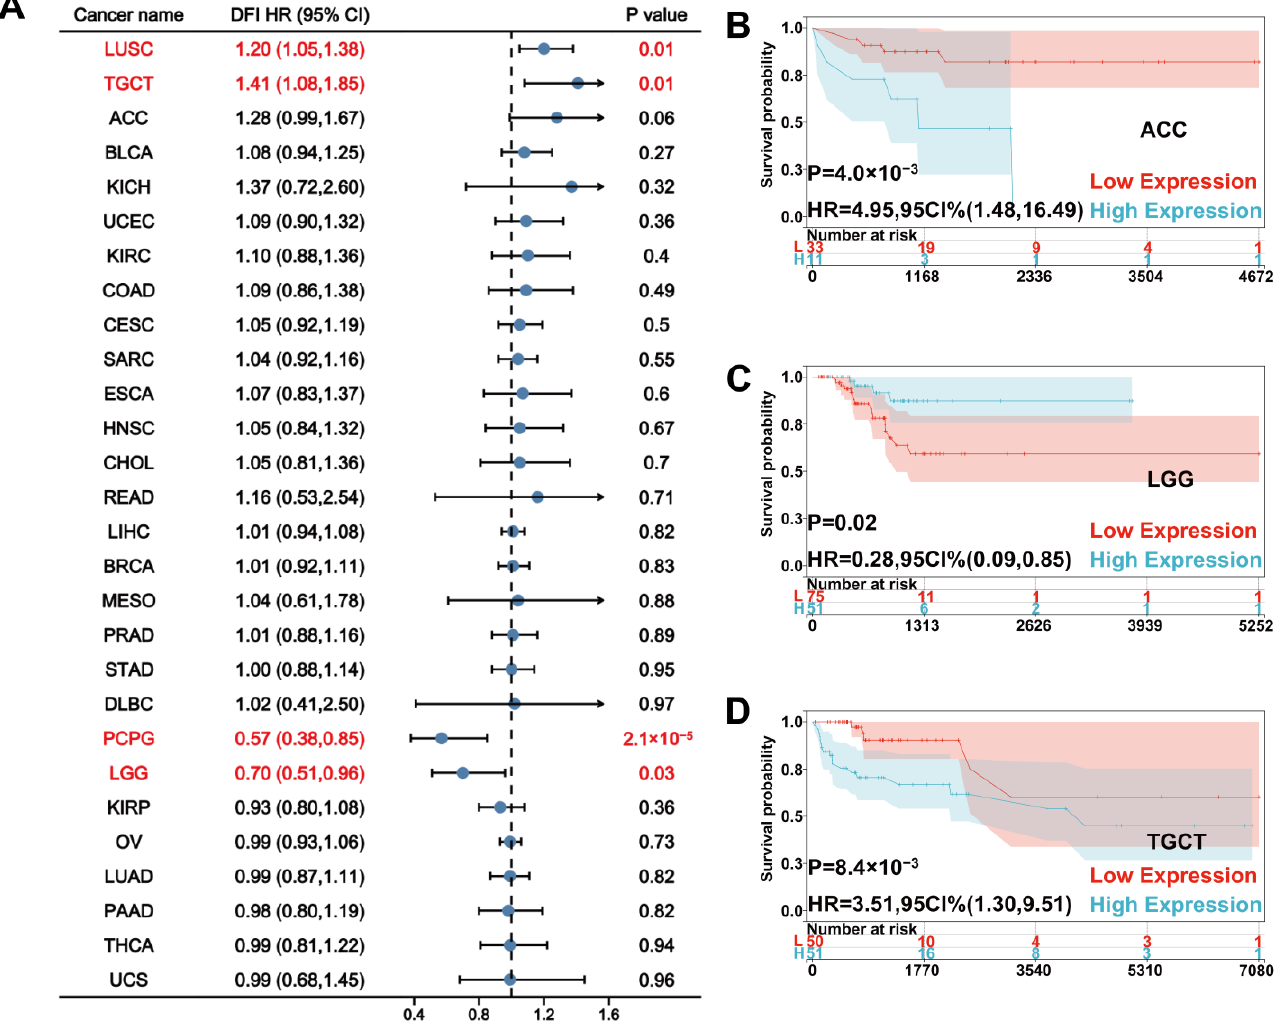
Figure 3. Relationship between UNC5A expression and patients’ DFI in pan-cancer. ( A ) The forest plot shows the relationship between UNC5A expression and DFI in pan-cancer. ( B – D ) Kaplan-Meier analysis shows the association between UNC5A expression and DFI in pan-cancer.